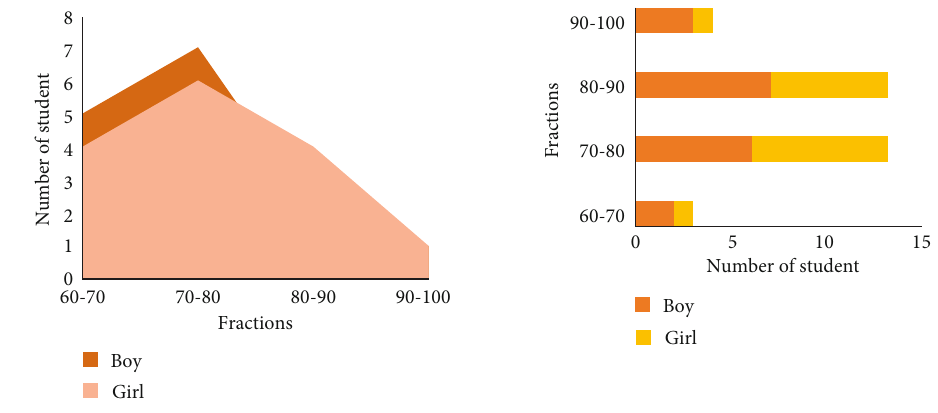
Figure 8: Changes in students ’ academic performance before and after intelligent networked